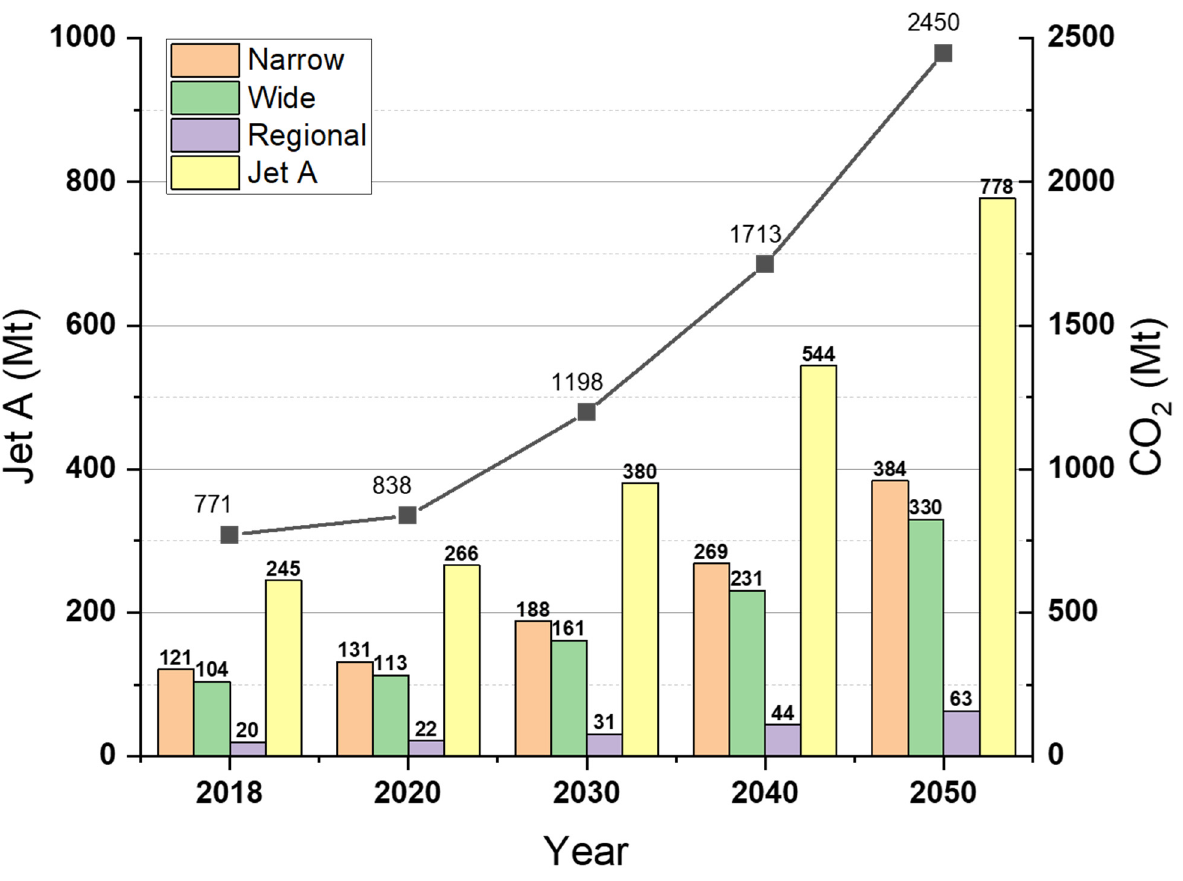
Figure 6. Total Jet A fuel demand and CO 2 emission estimation for aviation.